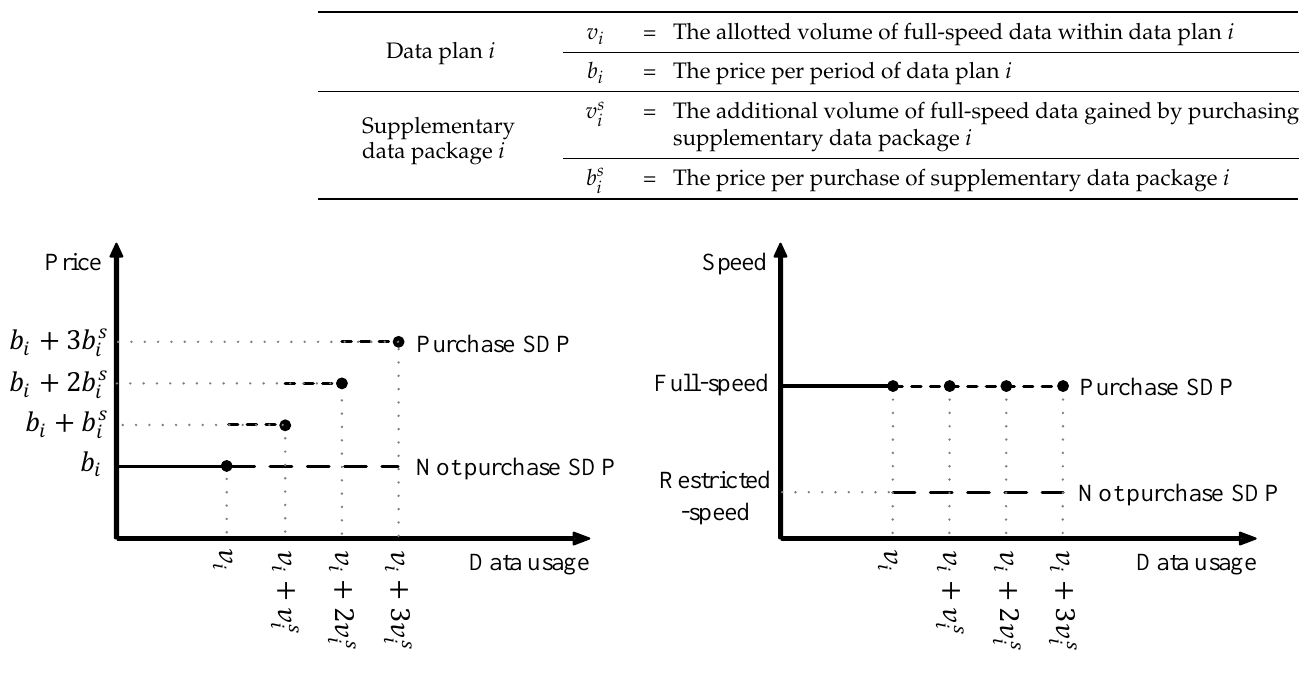
Figure 2. Mechanism of connection-speed-restriction